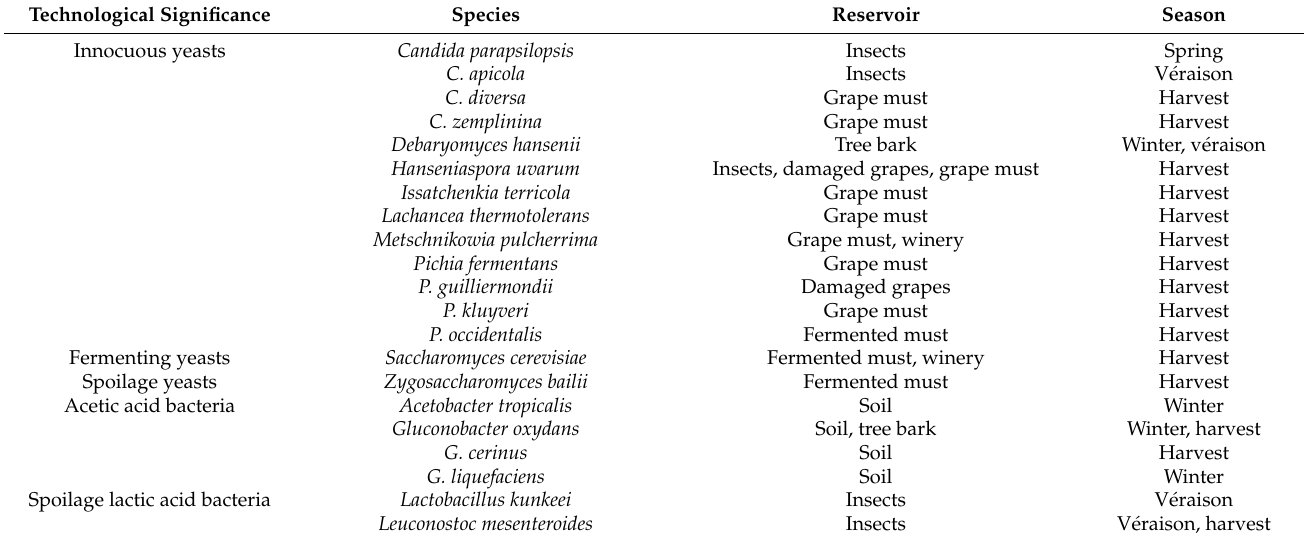
Table 6. Origin and dissemination of the Wine Microbial